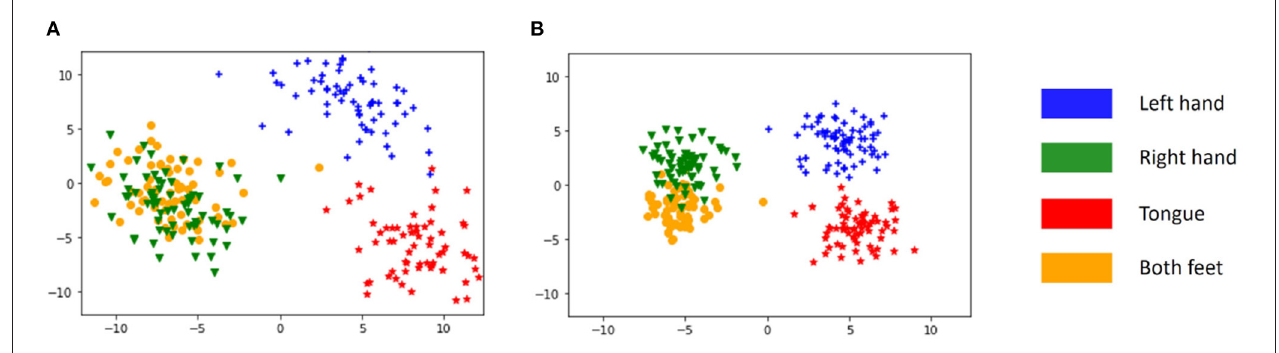
FIGURE 4 | Visualization of deep feature distributions of subject A07 on dataset IV-2a under two conditions. (A) Model with α lsr = 0.5 and α ct = 0. (B) Model with α lsr = 0.5 and α ct =